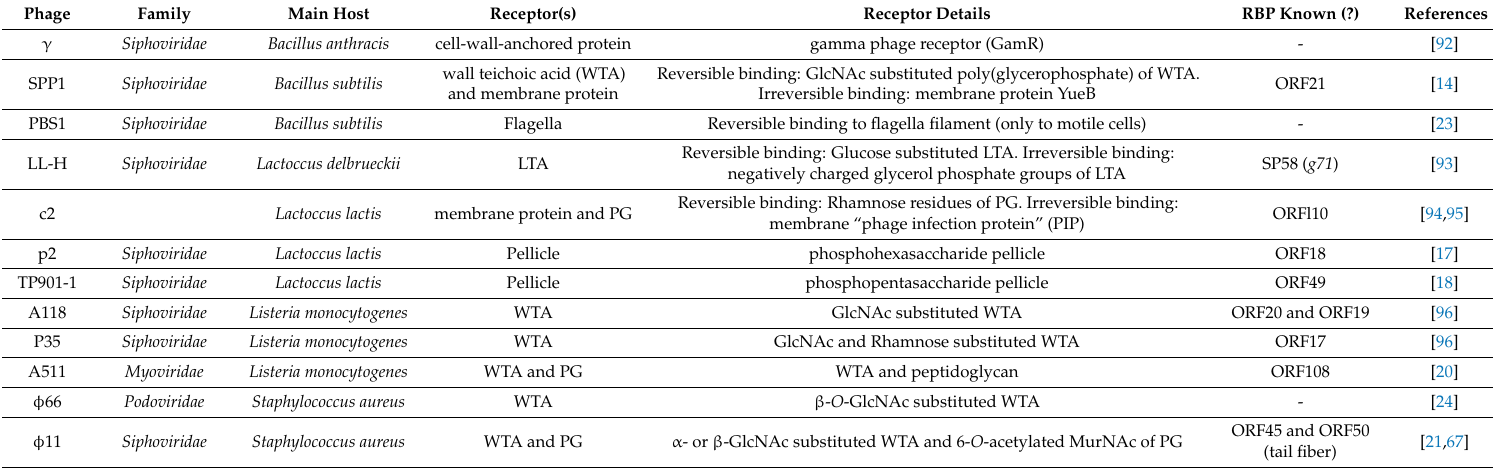
Table 1. List of Gram-positive-targeting phages and confirmed host cell